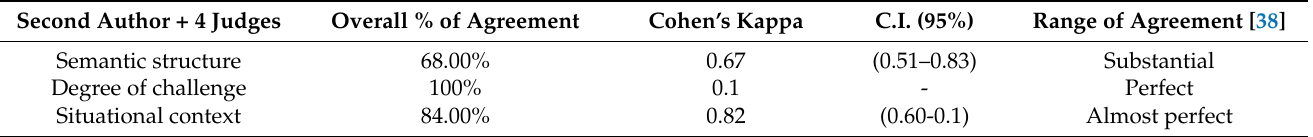
Table 2. Value and interpretation of Cohen’s Kappa index for the agreement between five judges. Second author of the study and four Doctors of Education and Educational